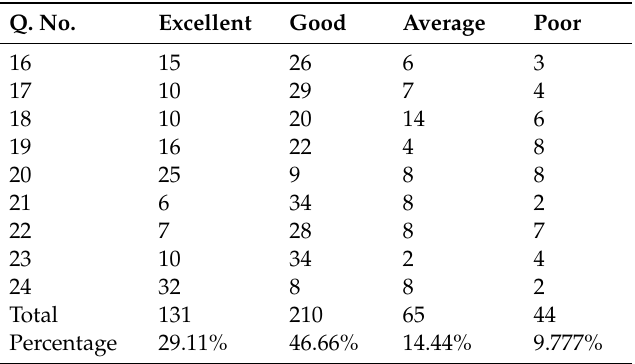
Table 7. Group III based on Questions 16–24.